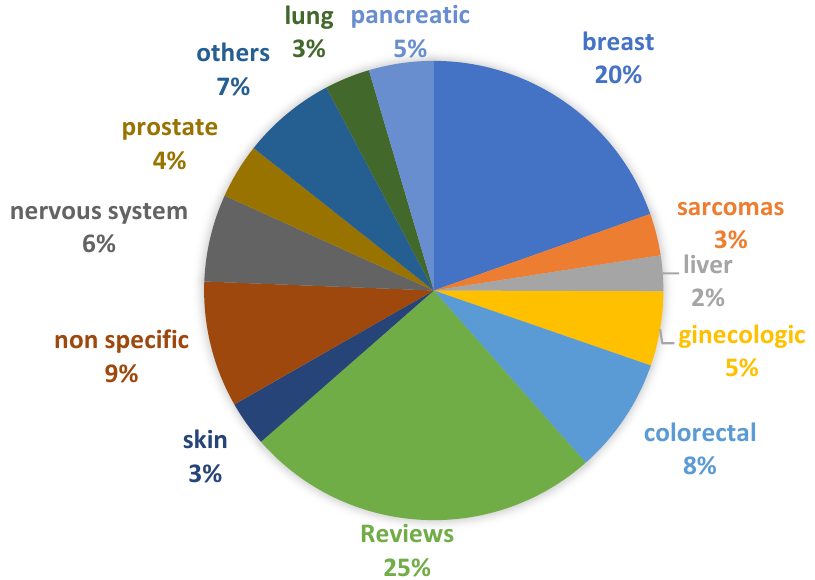
Figure 3. Types of cancer that are represented in 3D models (from the search mentioned in Figure 2). In “others” are included thyroid, renal, gastric, mesothelioma, bladder, head and neck, and blood cancers. “Non-specific” refers to papers that use cells from different cancer types (different cell lines) or do not use cancer cells in the model. “Reviews” also include opinion papers and book chapters.